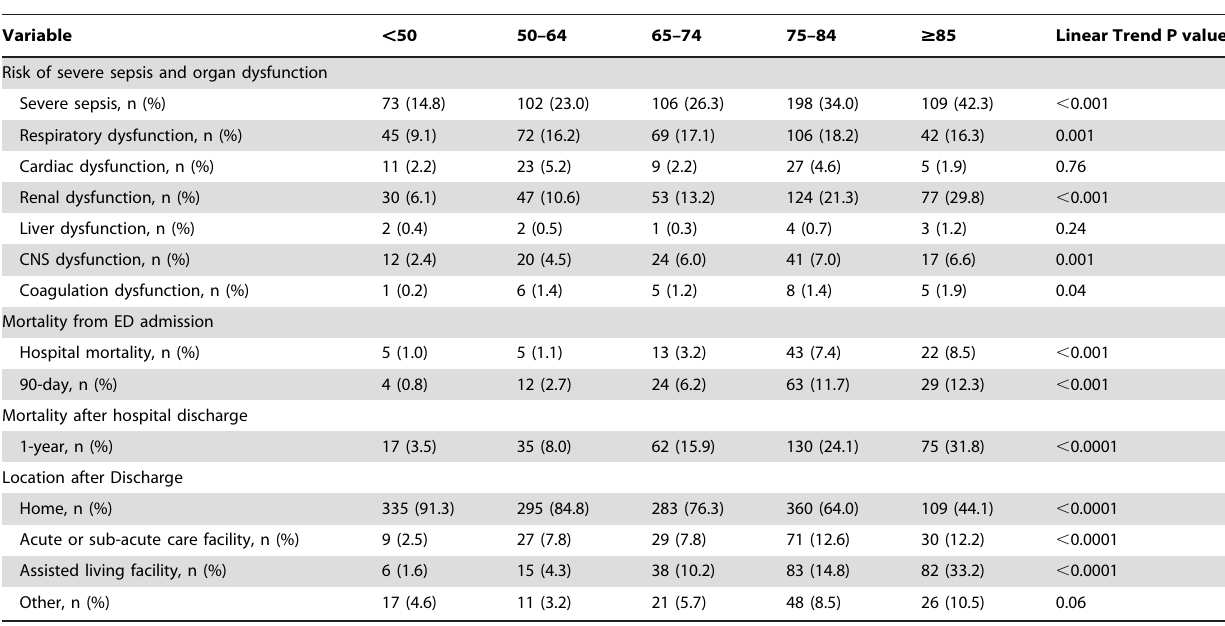
Table 2. Hospital outcome and mortality stratified by